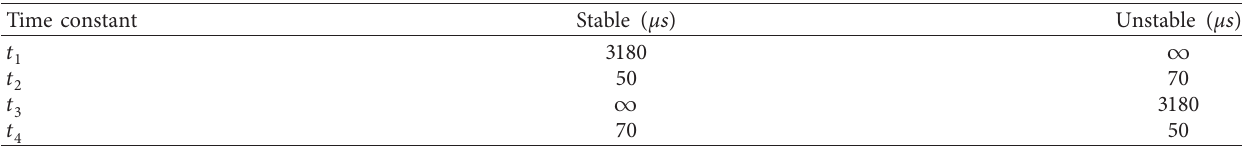
and t ) used NAB values, but 􏽥 R (parameters t and t ) 1 2 3 4